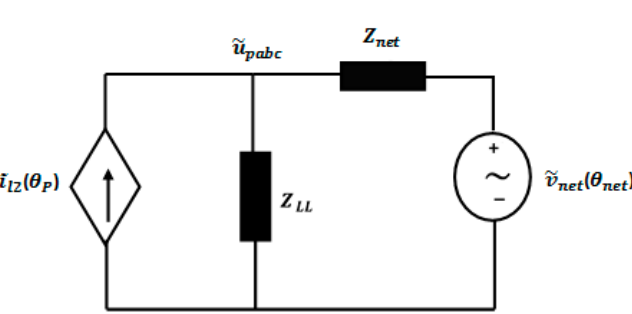
Figure 5. Simplified equivalent circuit of studied micro-grid and grid-side converter.